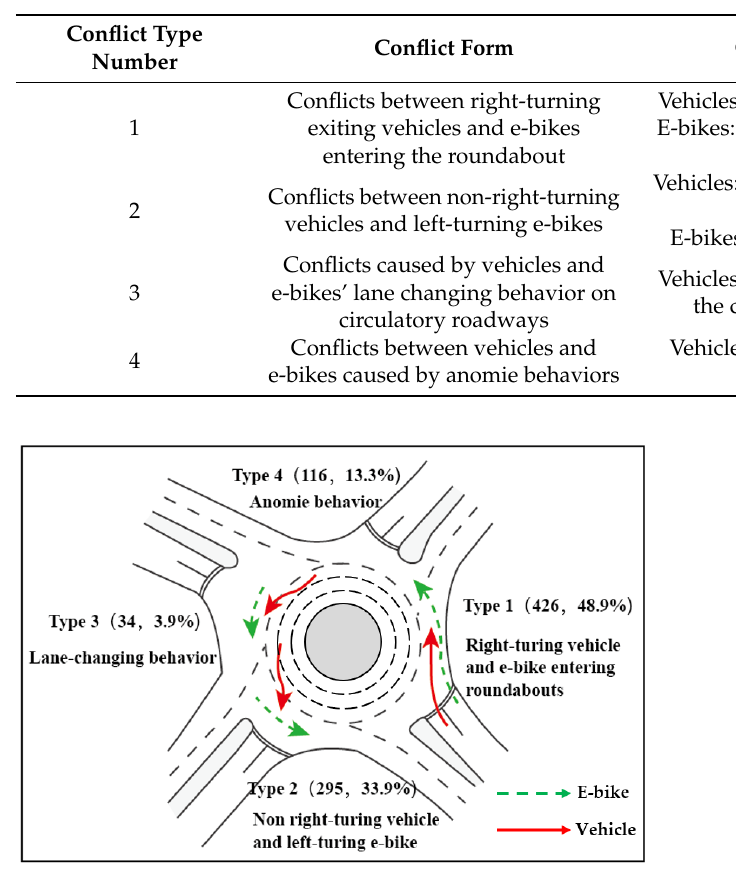
Table 5. Conflict Types at Roundabouts.